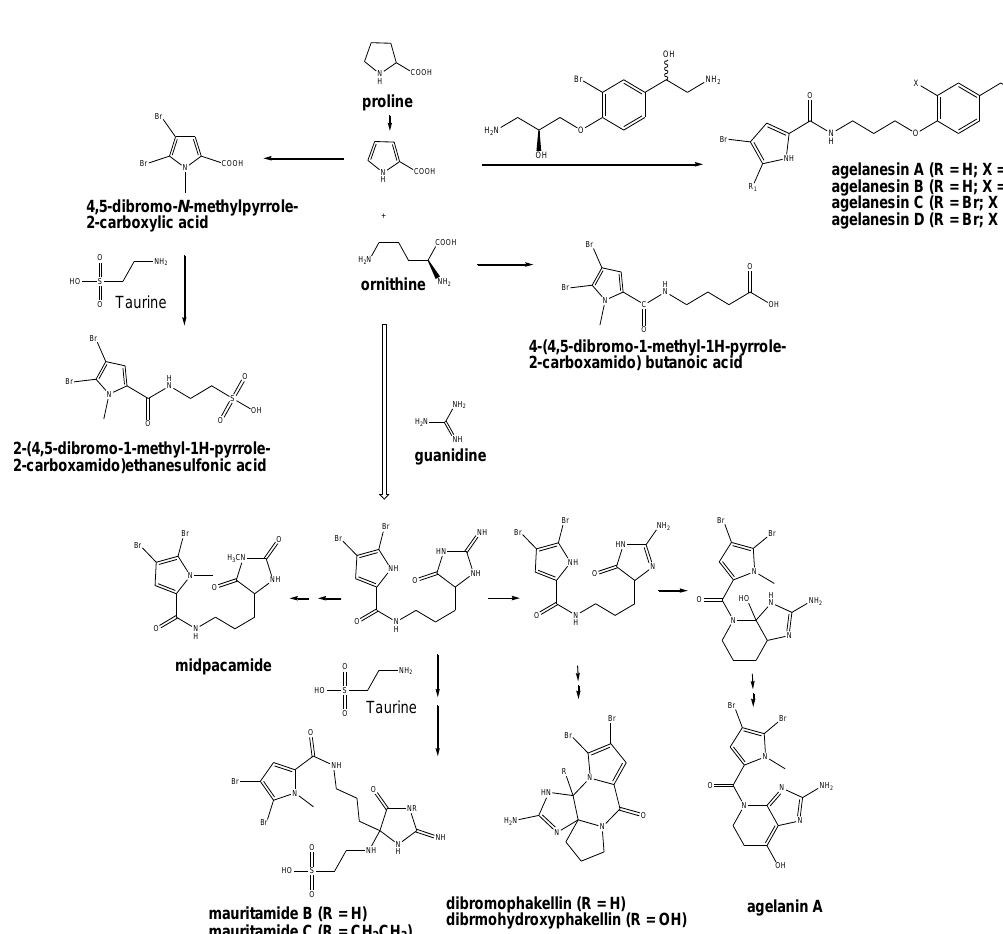
Figure 8. Proposed chemical pathway leading to several A. linnaei